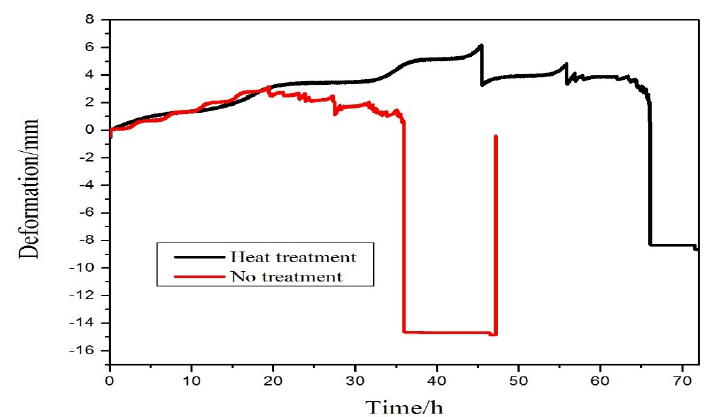
Figure 2. The deformation–time curve of the samples.